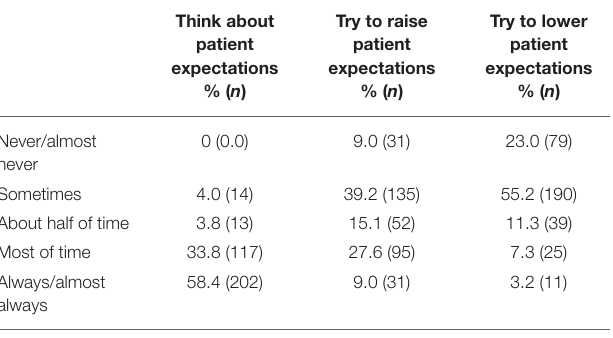
TABLE 3 | Importance of patient and psychiatrist